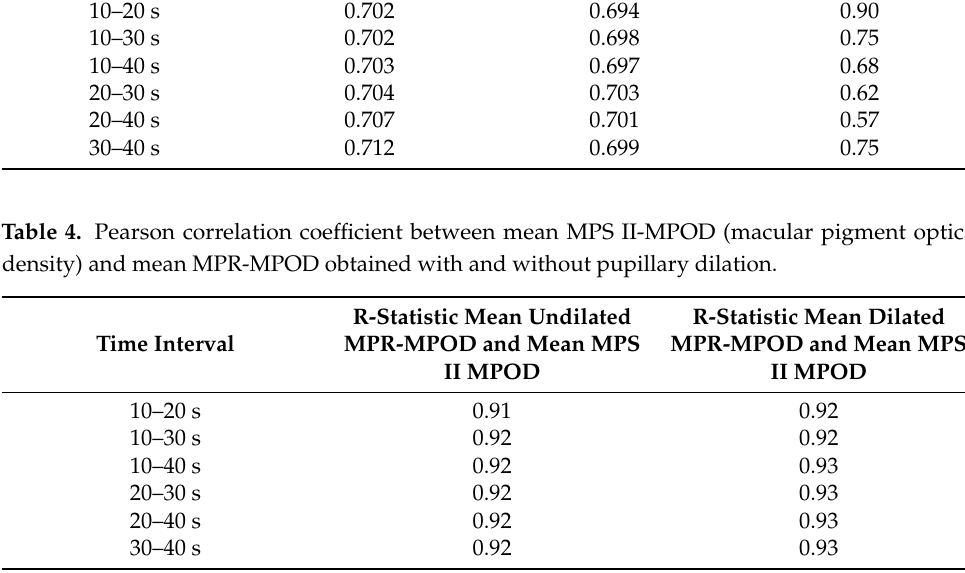
Table 3. Mean Macular Pigment Reflectometry MPOD (macular pigment optical density) obtained with and without pupillary dilation. Dilated MPOD Undilated MPOD Paired Samples Average of First and Average of First and Time Interval t -Test p -Value Second Second Measurement Measurement